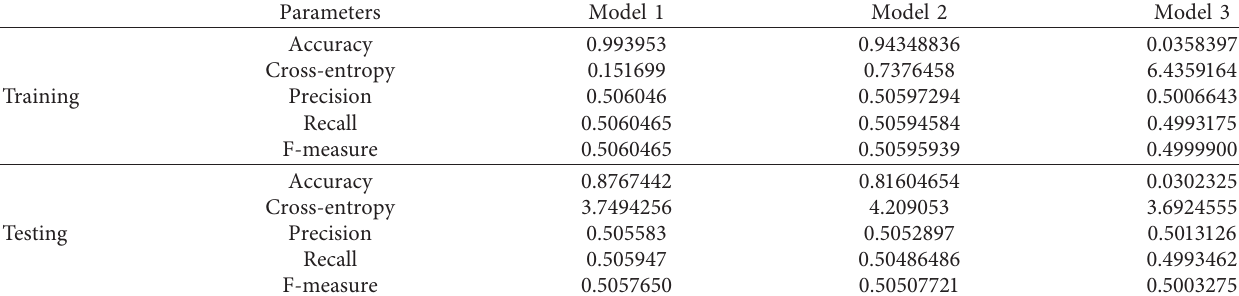
Table 4: Performance parameters evaluation on training and testing data.